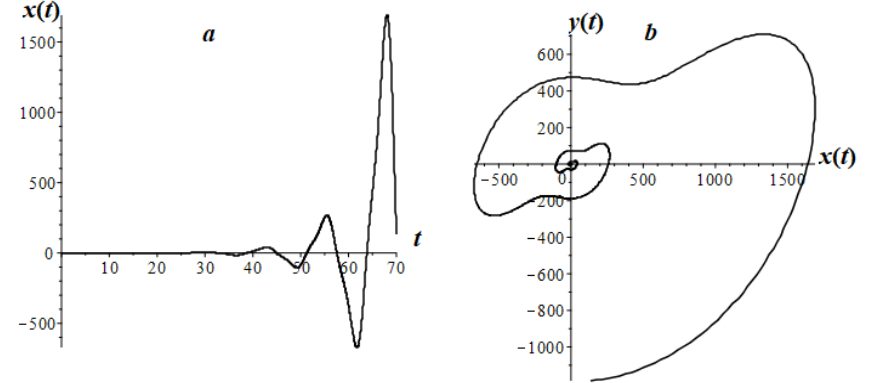
Figure 18. Parametric resonance of the Mathieu fractional oscillator at β = 1.8: ( a ) oscillogram; ( b ) phase trajectory.